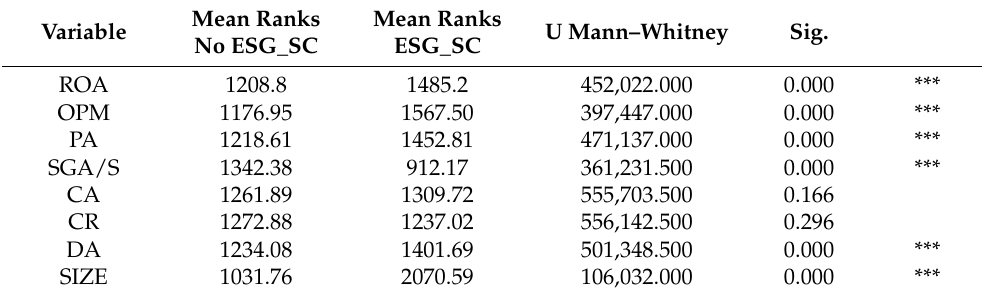
Table 3. Comparison between the groups (ESG_dum = 0 vs. ESG_dum = 1)—univariate analysis.